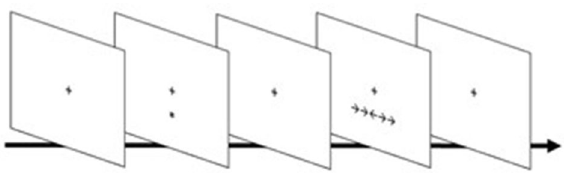
Figure 1. ANT trial sequence showing the screens order, with spatial cue and incongruent target as